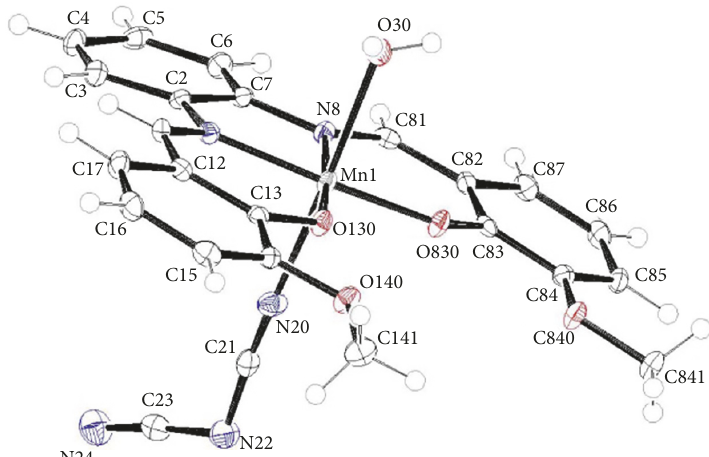
Figure 7: ORTEP view of the environment around the manganese ion in complex 1 .